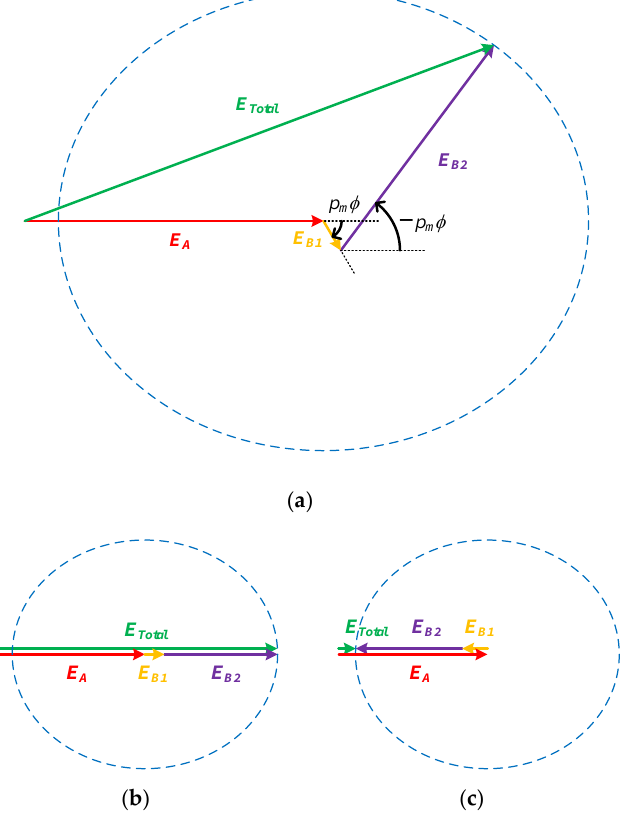
Figure 7. Back EMF vector graph. ( a ) Showing diagram; ( b ) maximum total back EMF position ( 𝑝 𝑚 𝜙 = 0 ∘ ); ( c ) minimum total back EMF position ( 𝑝 𝑚 𝜙 = 180 ∘ ). ( p m φ = 0 ◦ ); ( c ) minimum total back EMF position ( p m φ = 180 ◦